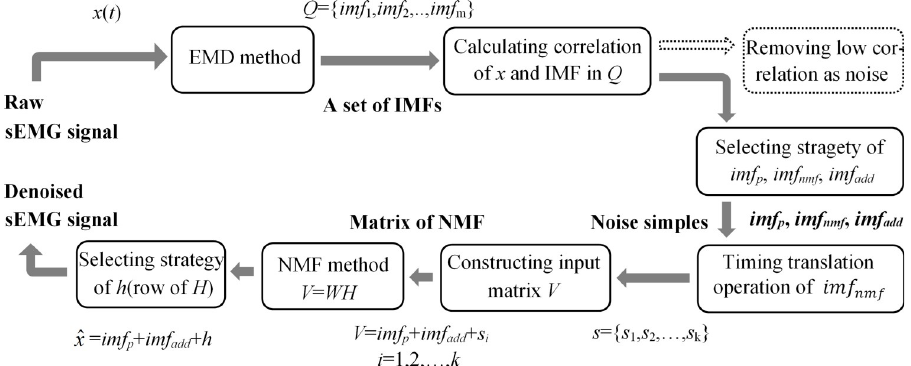
Fig 2. Concept flowchart of the proposed NMFSEMD method for